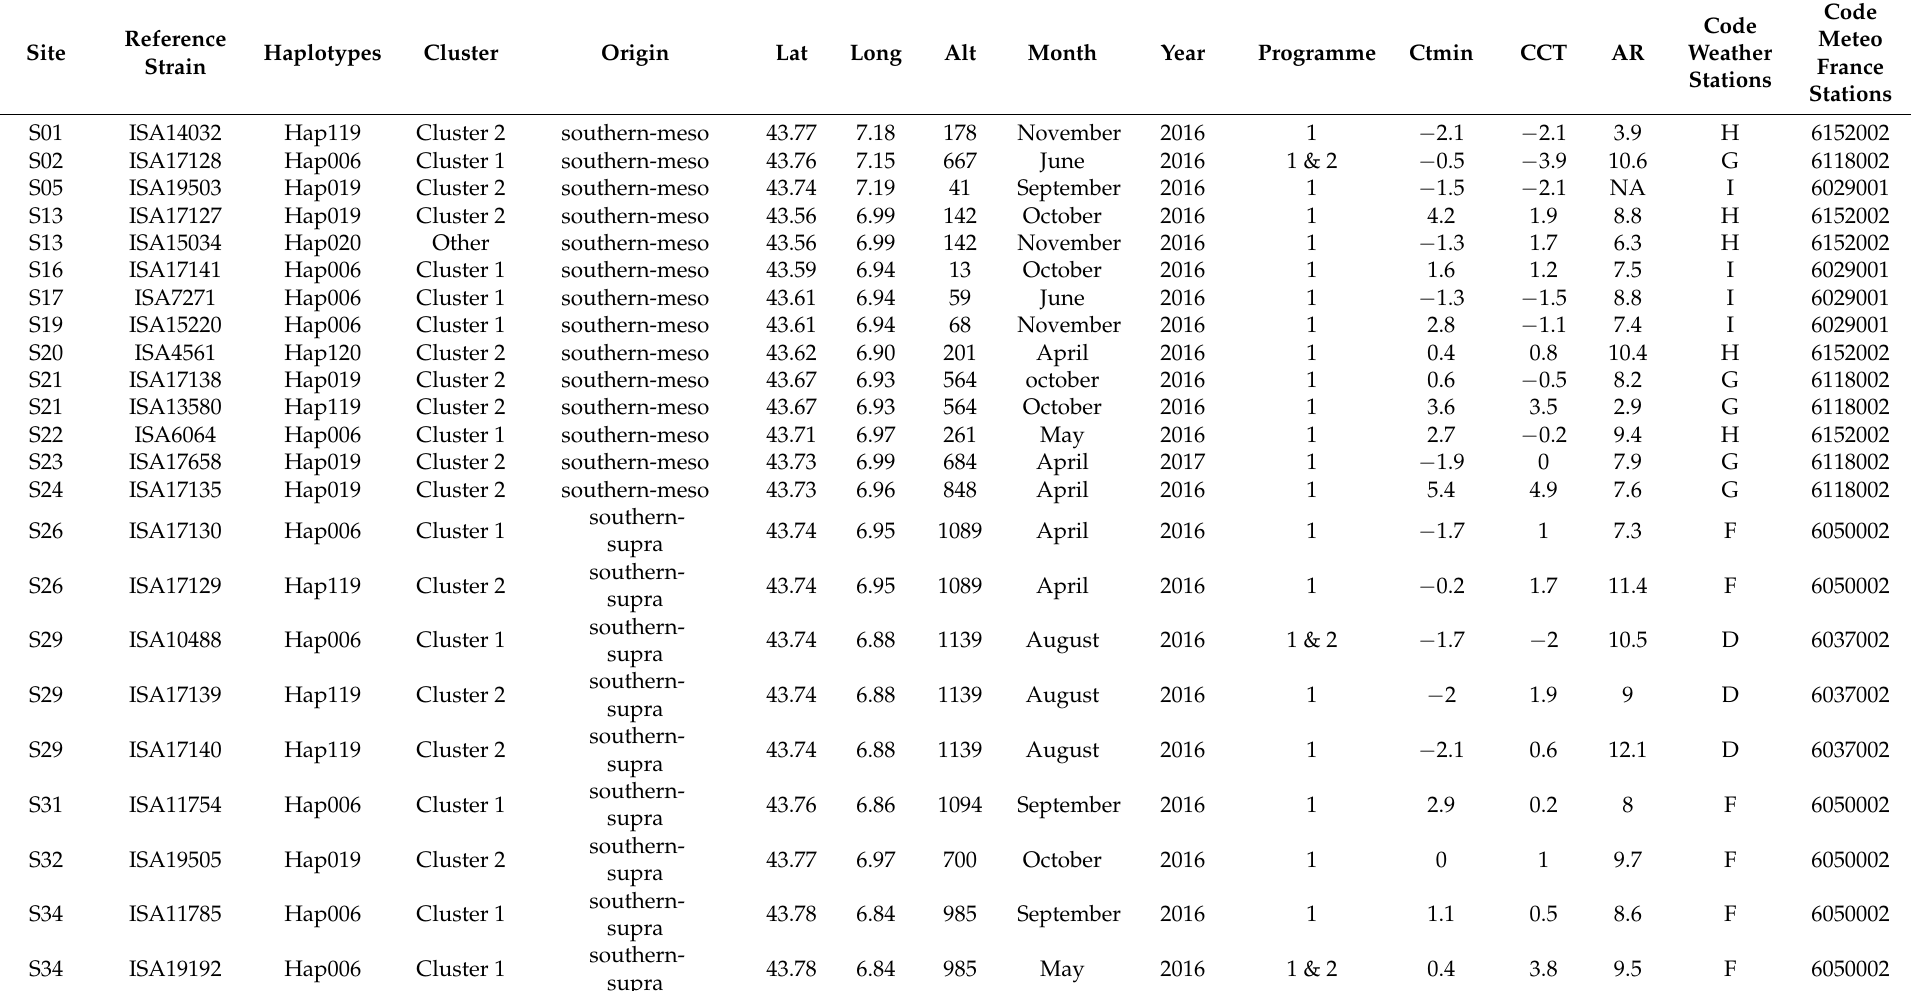
Table 1. Summary of reference Trichogramma cacoeciae strains used for the phenotyping characterization and temperature values of CTmin, CCT, and